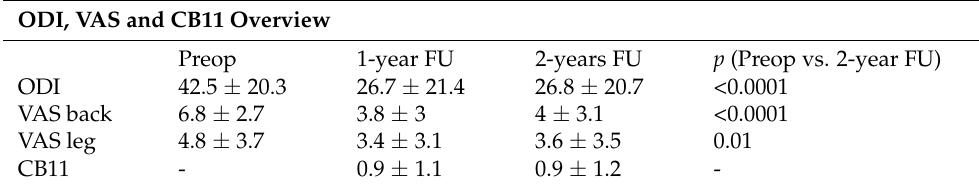
Table 4. Overview of ODI, back and leg VAS, and CB11 values over time. ODI, VAS and CB11